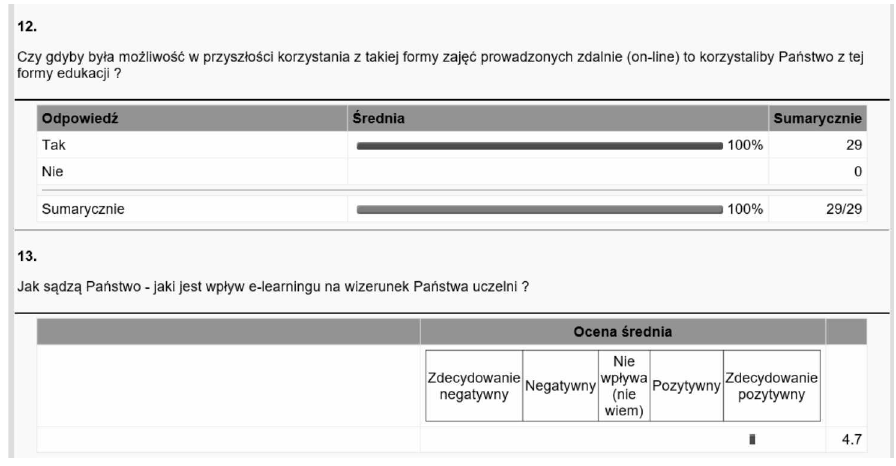
Figure 5. Examples of students’ responses to survey questions 12–13